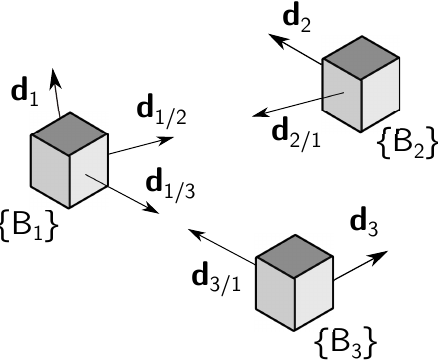
Figure 1. Three-vehicle heterogeneous